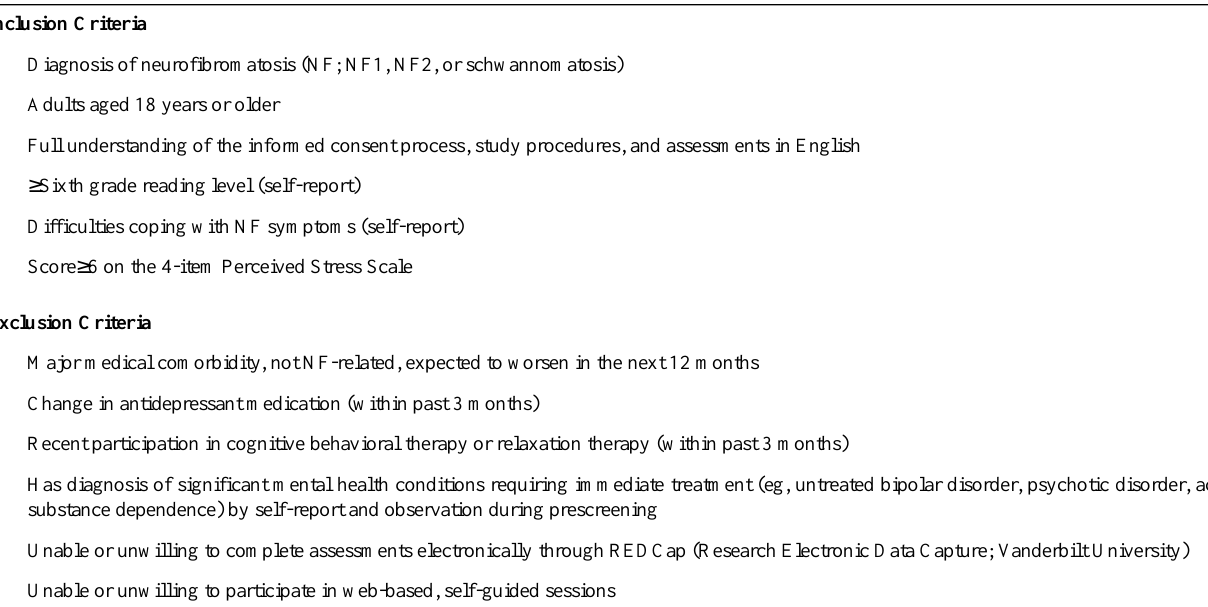
Textbox 1. Study inclusion and exclusion